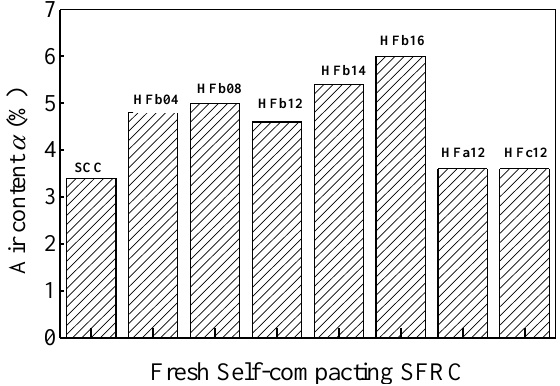
Figure 7. Air content of fresh self-compacting SFRC.